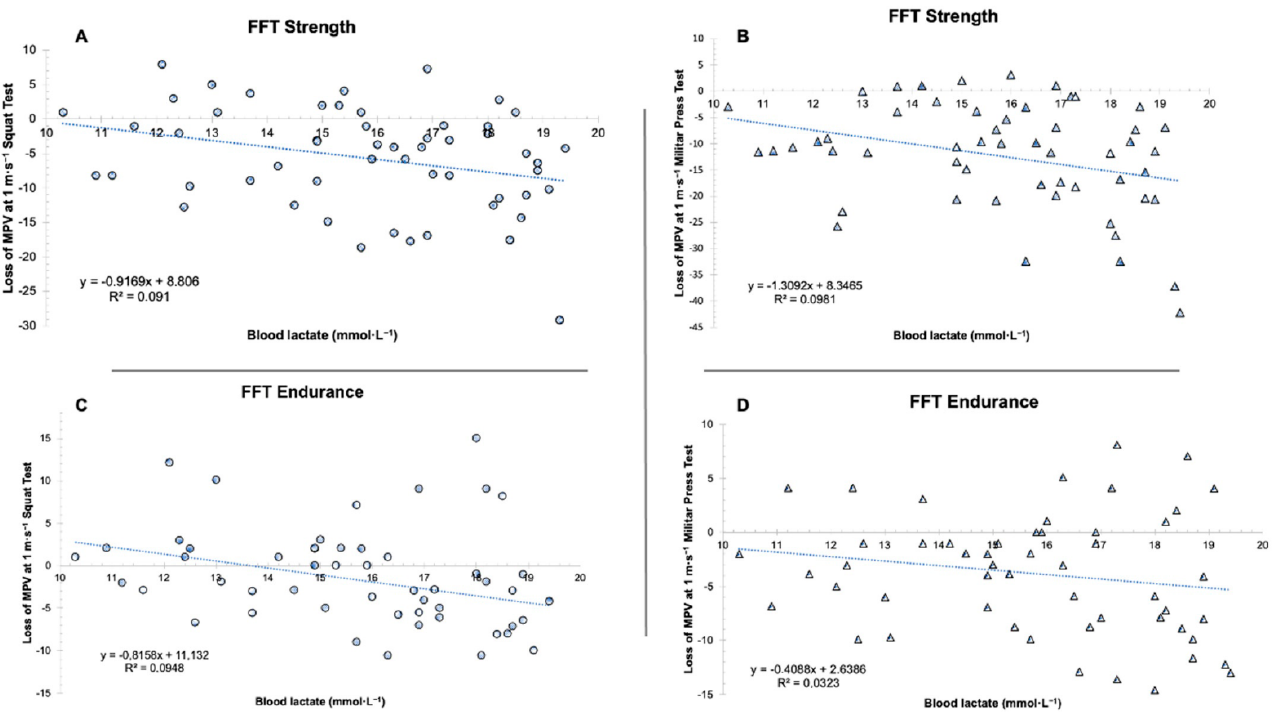
Figure 4. ( A ) Relationship between loss of MPV at 1 m·s −1 Squat Test and blood lactate in FFTstrength ( R 2 = 0.091, p = 0.027), ( B ) relationship between loss of MPV at 1 m·s −1 Military Press Test and blood lactate in FFTstrength ( R 2 = 0.0981, p = 0.021), ( C ) relationship between loss of MPV at 1 m·s −1 Squat Test and blood lactate in FFTendurance ( R 2 = 0.0948, p = 0.024), ( D ) relationship between loss of MPV at 1 m·s −1 Military Press Test and blood lactate in FFTendurance ( R 2 = 0.0323, p = 0.194).